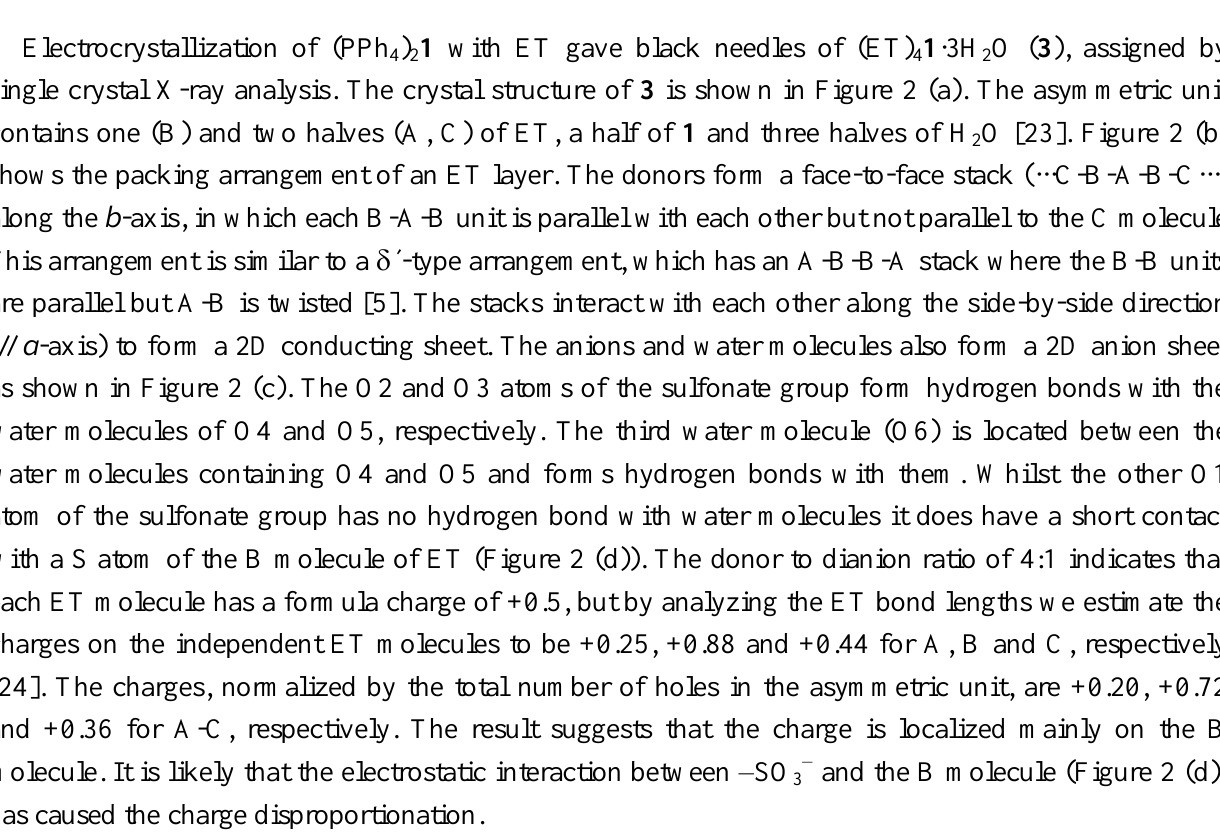
1 ·3H O ( 3 ). (b) Packing motif of the donor layer. 4 2